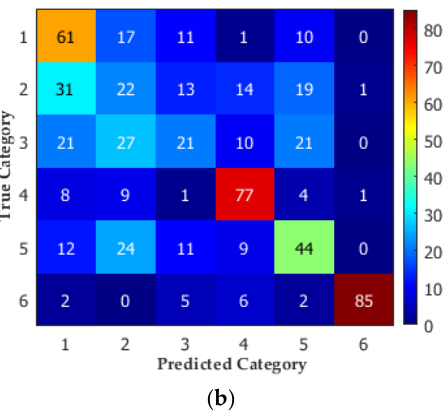
Figure 21. The topography classification performance of mixed three multiscale surface filtered image data sets: ( a ) the effect of increasing the training set size on the classification accuracy and ( b ) a confusion matrix for six surface category classifications by using 21% of the mixed data set for training.